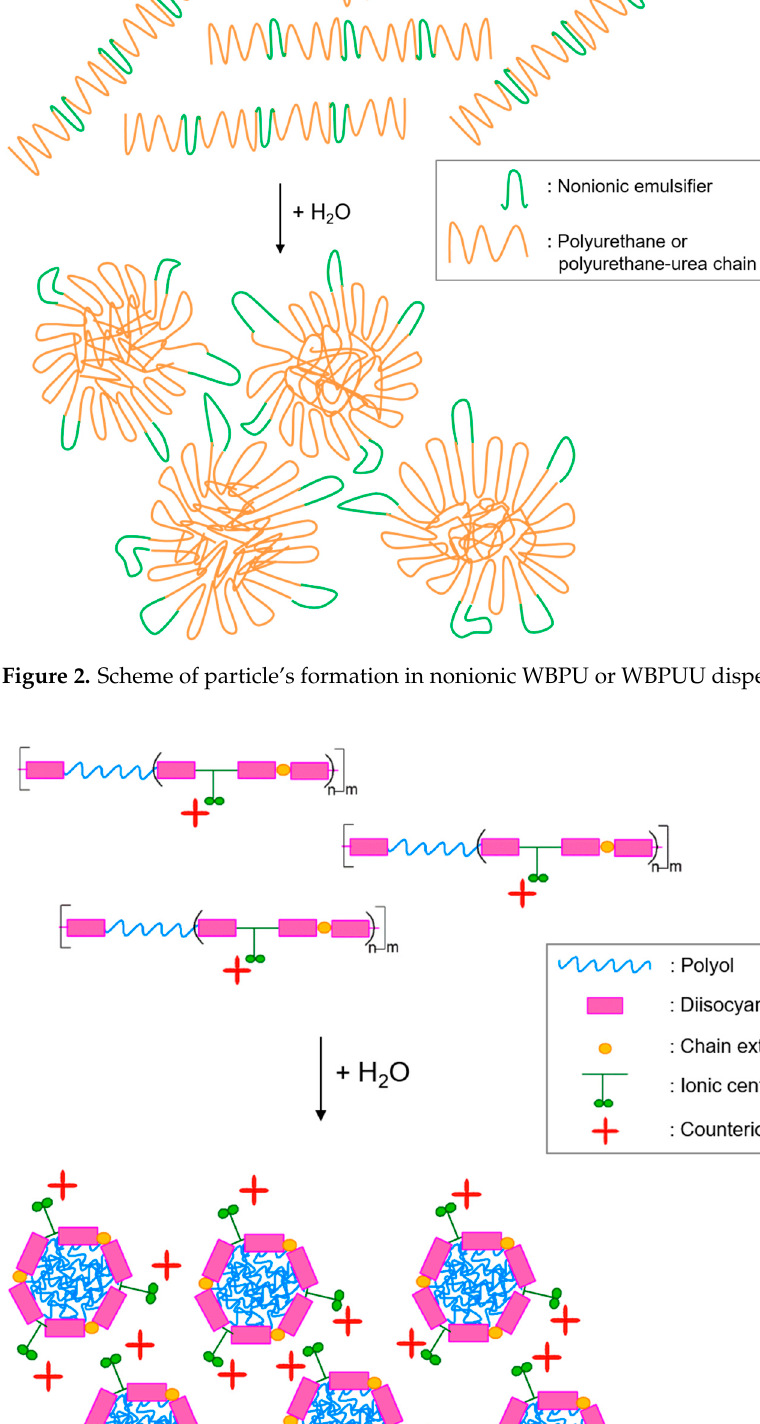
ated in the inner part of particles making their core [18]. Thereby, the electrical double layer’s interference among particles results in their mutual repulsion, leading to disper- sion stabilization through a mechanism based on the repulsive electrostatic interactions [1,28]. 3. WBPU and WBPUU Synthesis Methods 3.1. Overview of The Most Used Synthesis Procedures and Their Characteristics The WBPU and WBPUU production methods progressed over the years to increas- ingly sustainable synthesis routes. The initial method, namely the acetone method, evolved into designing an alternative method, the prepolymer method, aiming to elude the restrictions of the patent held by Bayer (e.g., first development on polyurethane dis- persions started in the 1960s, and later in the 1980 the continuous production of disper- sions was implemented) [29,30]. Nevertheless, the use of N-methyl-2-pyrrolidone (NMP), a highly toxic solvent widely used to dissolve the hydrophilizing agent (e.g., DMPA) in the prepolymer method, required the modification of the process to avoid legislation lim- itations regarding the NMP. In this context, the modified prepolymer method displaced the conventional prepolymer method, leading to NMP-free dispersions. Even with “green” connotations, since solvent-free products are achieved, these processes present the disadvantage of needing organic solvents during the synthesis. Thus, current methods focus on developing green products through sustainable approaches, i.e., without using organic solvents during the synthesis. Considering the diversity of available synthesis methods and the wide range of chemical compositions, Table 1 summarizes these